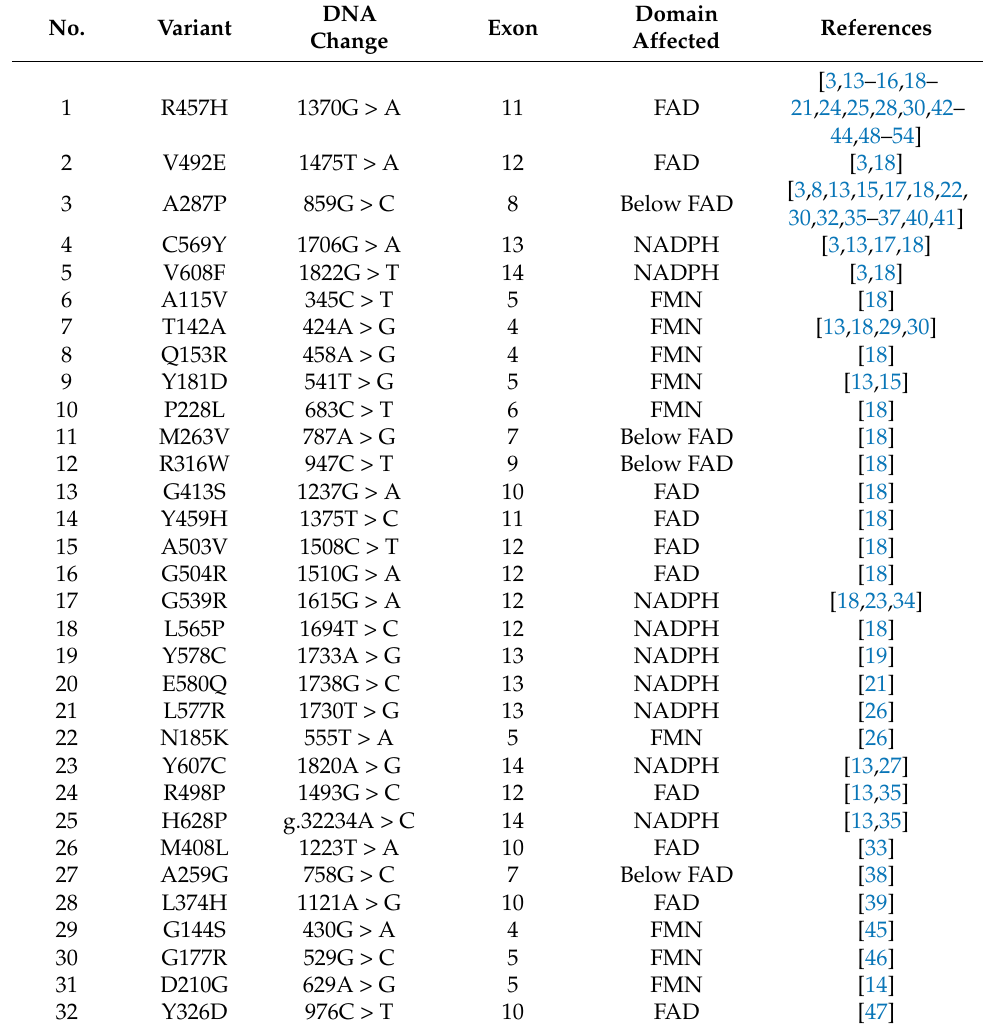
Table 2. List of missense mutations variants in